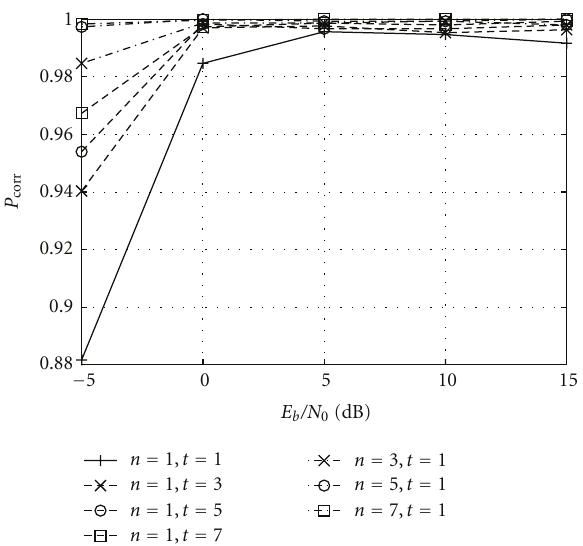
Figure 7: Probability of correct detection P corr versus observation time T obs for di ff erent numbers n of cooperative single antenna CR terminals and multiple antenna CR terminal with a variable number t of